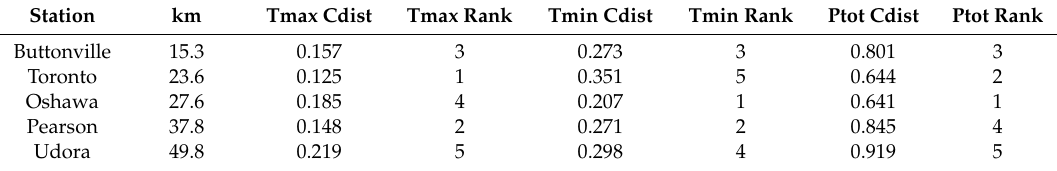
Table 1. The proximity (physical distance) of five surrounding weather stations in relation to the Toronto (Metro) Zoo and their climatic distance (Cdist) based on daily weather data from 1990 to 1992. Station km Tmax Cdist Tmax Rank Tmin Cdist Tmin Rank Ptot Cdist Ptot Rank Buttonville 15.3 0.157 3 0.273 3 0.801 3 Toronto 23.6 0.125 0.351 Pearson 37.8 0.148 0.271 4 Udora 49.8